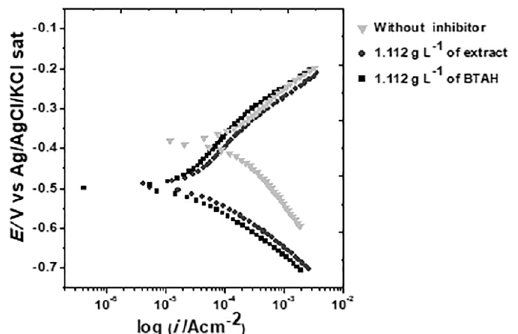
Figure 9. Potentiodynamic polarization curves for CS - ASTM 1020 after 120 min immersion in 18.23 g L -1 HCl solution in the absence and in the presence of 1.112 g L -1 of inhibitors. extract. In addition, the IE as determined from the Tafel extrapolation method and from the gravimetric tests show high degree of concordance.